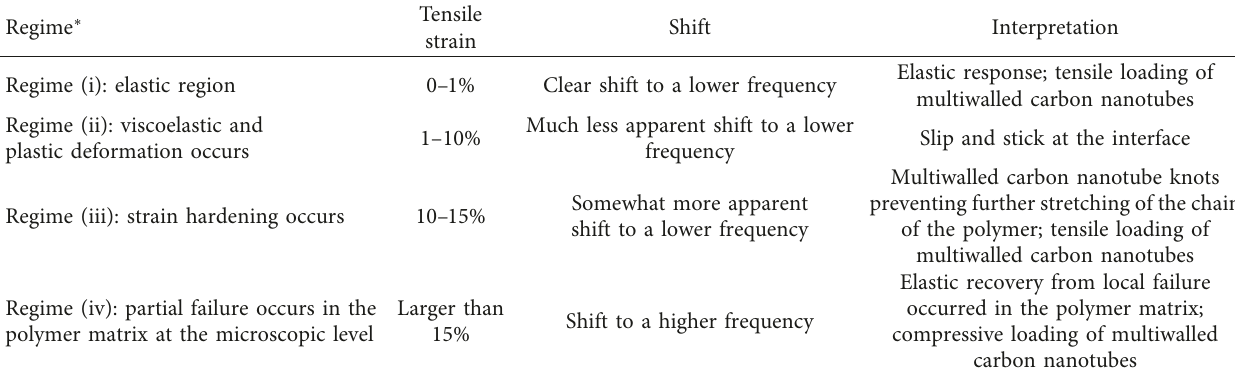
Table 1: Shift in Raman frequency (2691 cm − 1 ) as a function of the tensile strain applied to an ultrahigh molecular weight polyethylene nanocomposite reinforced with multiwalled carbon